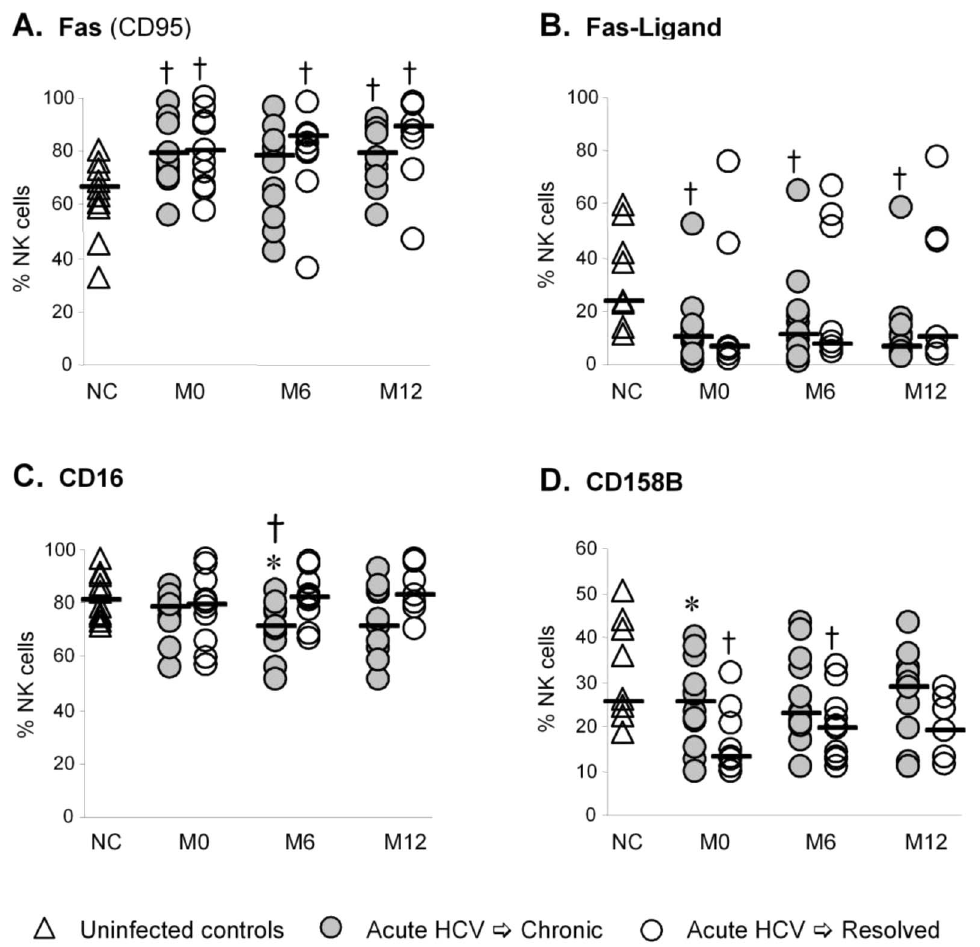
Figure 2. Phenotype of NK cells in acute HCV infection. Multi-parameter flow cytometric analysis was used to determine if the phenotype of NK cells was altered in acute HCV infection. Upregulation of Fas ( A ) and downregulation of Fas-Ligand ( B ) suggest activation of NK cells in acute HCV infection. Fas remains upregulated even after viral clearance. The decrease observed for NK CD16 expression in the chronically evolving patient group at month 6 ( C ) is consistent with altered NK subset distribution. Decreased expression of the inhibitory KIR CD158B ( D ) in the spontaneously resolving group at baseline suggests a genetic contribution to the outcome of acute HCV infection. * p , 0.05 chronic versus resolved; { p , 0.05 versus uninfected control (MWU) Abbreviations: NC=normal control;